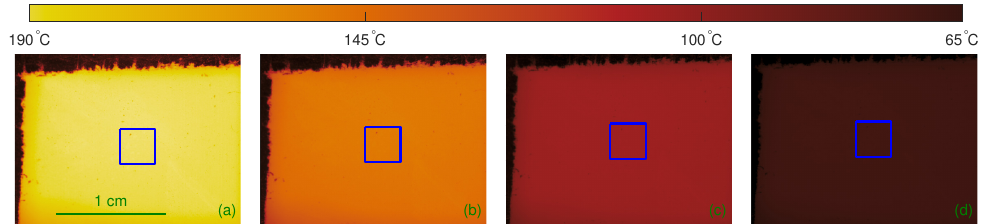
Figure 2. Examples of raw infrared camera images during the spray cooling process at different temperatures: ( a ) 190 ◦ C, ( b ) 145 ◦ C, ( c ) 100 ◦ C, and ( d ) 65 ◦ C. The same magnification factor applies to all